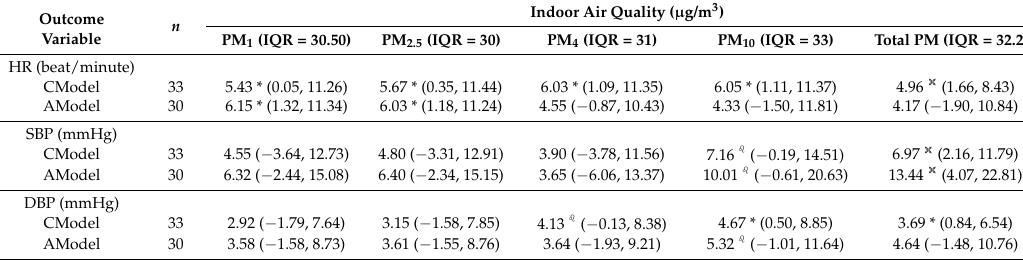
Crude model: adjusted for age and gender. Adjusted model: adjusted for age, gender, BMI, smokers in house, hypertensive, prescription medicine, and McAuley’s ISI. For the HR variable, natural logarithmic transformation was used. The estimated coefficients corresponding to the expected geometric mean of the HR were then back transformed using an exponential function.  p < 0.01, * p < 0.05,  p <